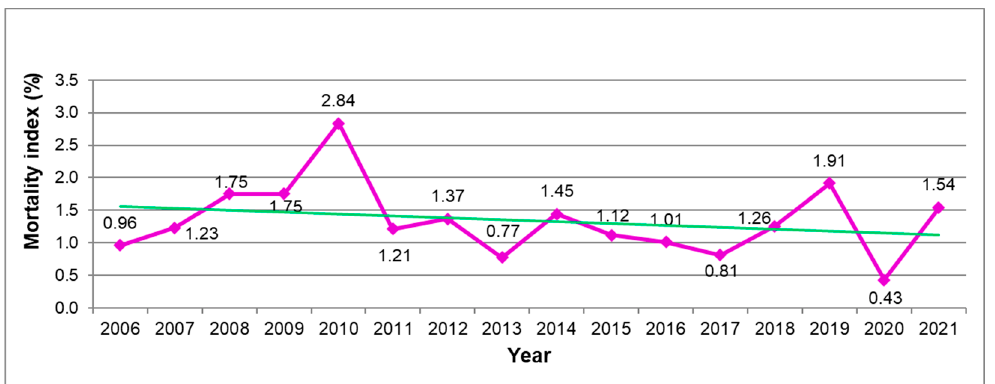
Figure 3. Annual number of overall fatally and non-fatally accidented (n = 7697) vs. fatally acci- dented (n = 97) recreational mountain-bikers in the Austrian Alps from 2006 to 2021. Values are absolute frequencies.